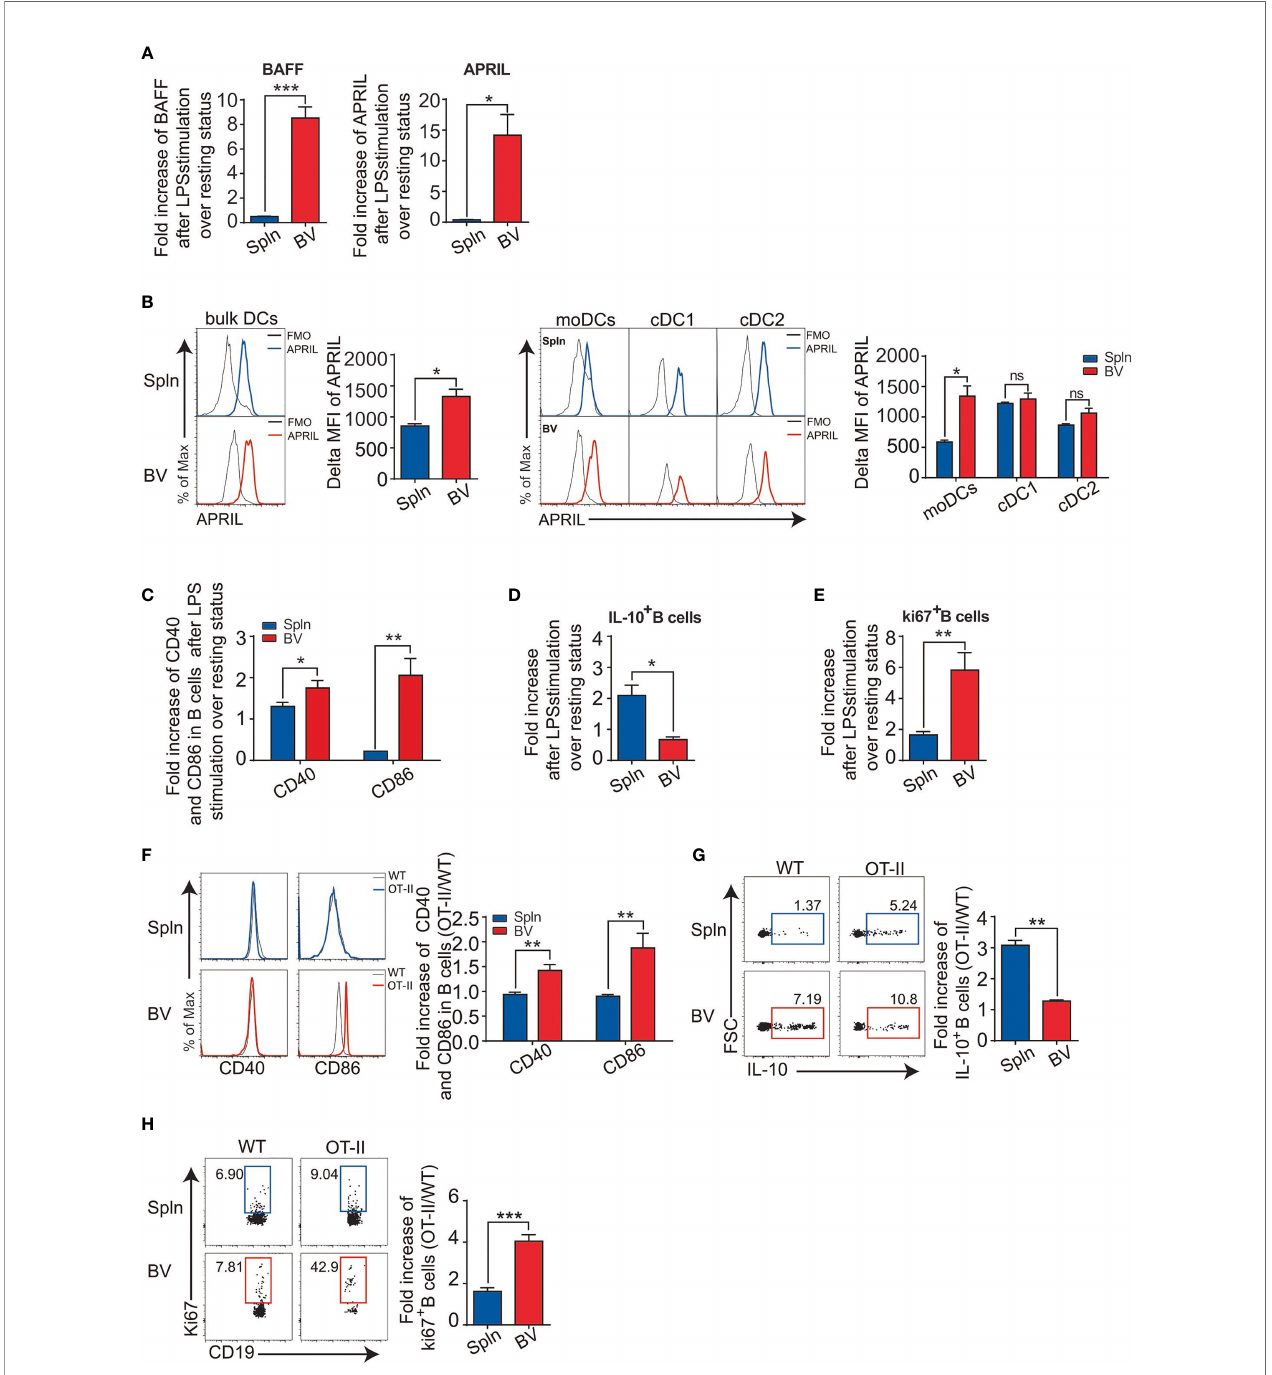
FIGURE 8 | DC-derived B-cell activation factors and antigen-speci fi c B-cell activation in vascular tissues and spleen. WT mice were i.v. injected with LPS or PBS before their BV and Spln were taken. Bar graphs showed the fold increase of BAFF and APRIL mRNA in the two tissues (A) ; APRIL expression (B) on the DCs and their subsets from the two tissues; and costimulatory molecules CD40 and CD86 on B cells (C) , IL-10-producing B cells (D) , and proliferated B cells (E) from the two tissues. Shown here are representative plots of at least three biological replicates. Alternatively, WT and OT-II mice were i.v. injected with OVA/LPS before their BV and Spln were taken for FACS analysis of the fold increase of CD40/CD86 on B cells (F) , the percentage and fold increase of IL-10 + B cells (G) , and the percentage and fold increase of Ki67 + B cells (H) in OT-II over WT in BV and Spln. Shown here are representative plots of experiments with at least two biological replicates. The data are shown as mean ± SEM ( n = 2 – 10 mice) and analyzed using Student ’ s t -test. * p < 0.05; ** p < 0.01; *** p < 0.001. ns, no signi fi cant